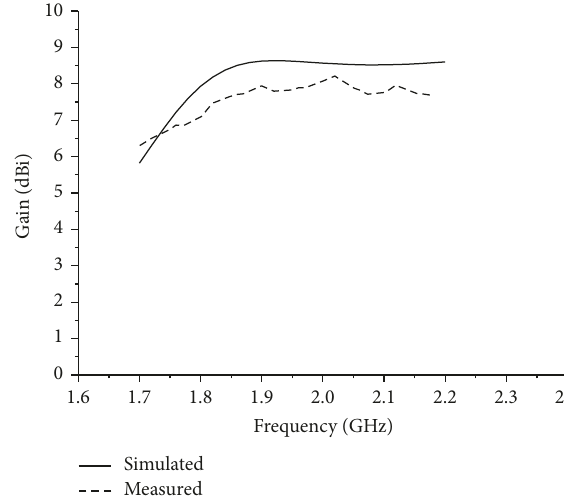
Figure 7: Antenna gains against frequency of the proposed